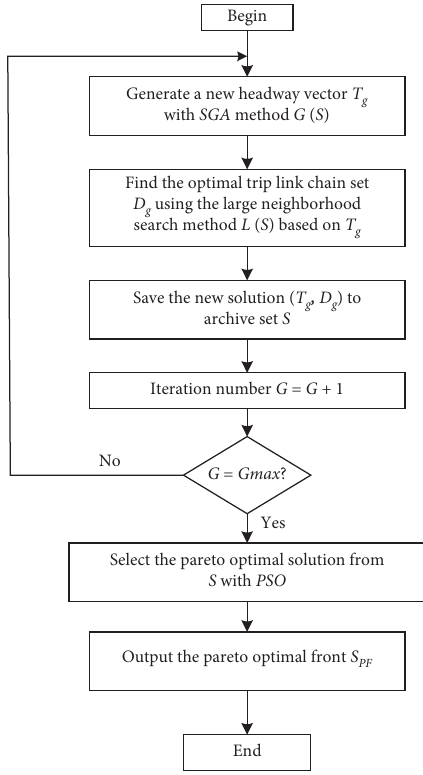
Figure 7: The framework of the multiobjective hybrid